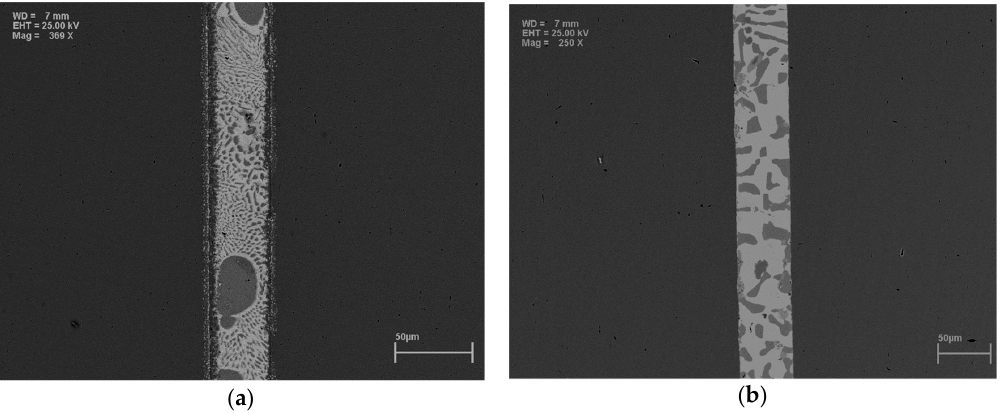
Figure 1. Scanning Electron Microscopy (SEM) images of cross sections of the resultant braze joint